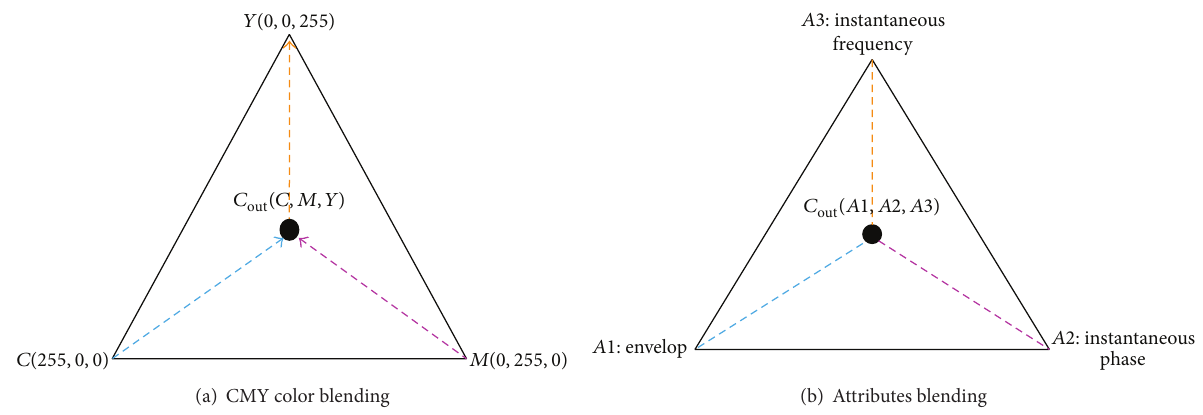
Figure 3: Diagram for CMY color blending and seismic attributes blending in CMY